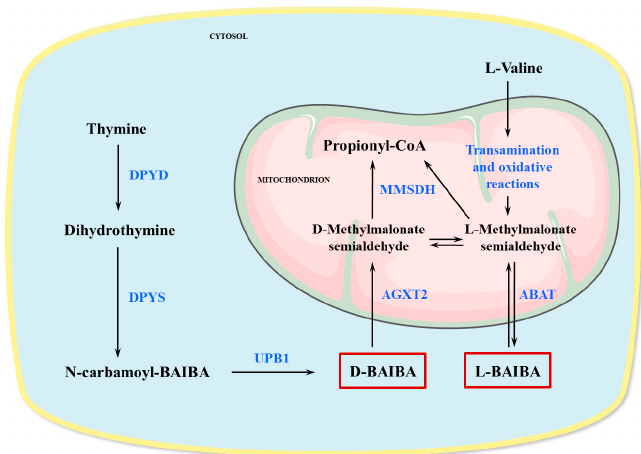
Figure 1. Production and metabolism of β -aminoisobutyric acid (BAIBA). D-BAIBA is